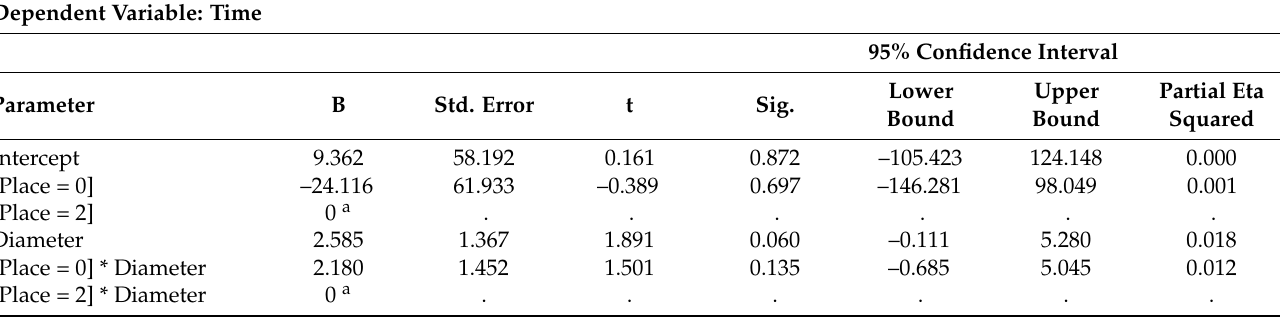
Table 9. SPRUCES—parameter